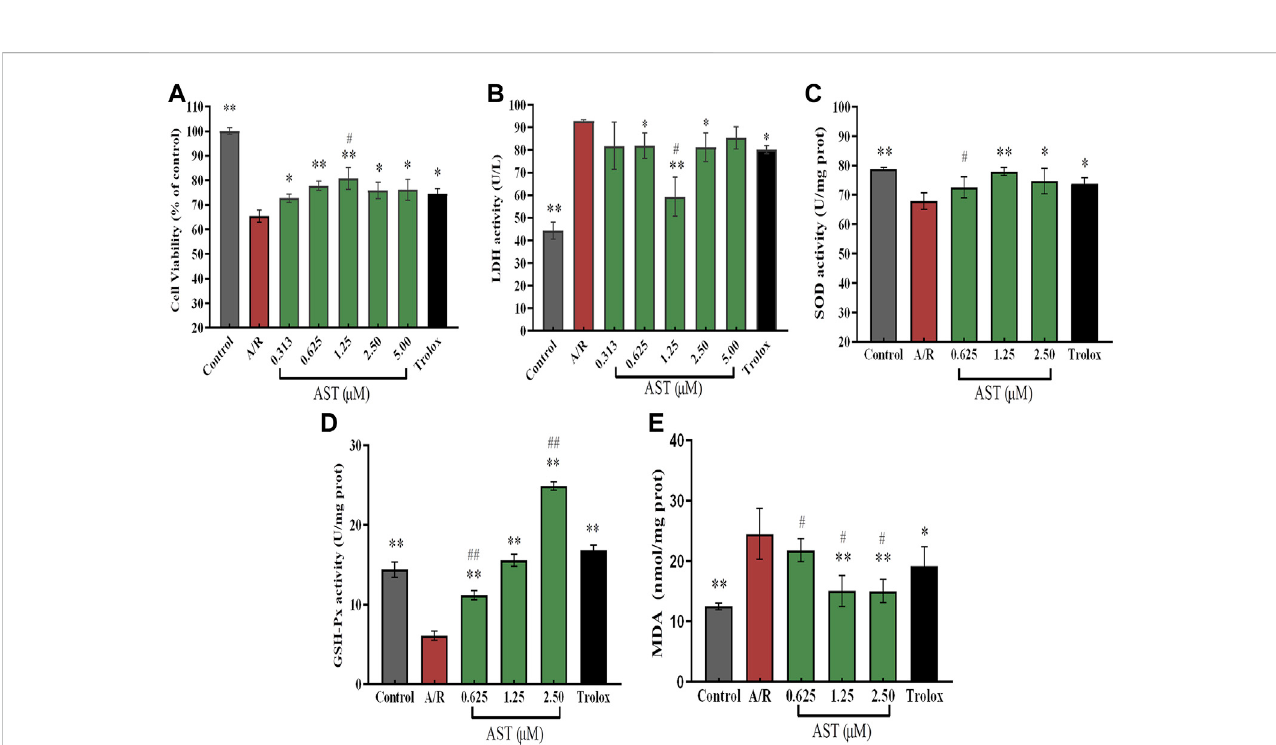
FIGURE 2 Astaxanthin alleviates A/R damage to H9c2 cardiomyocytes by maintaining cellular activity (A) , increasing expression of antioxidant enzymes (C,D) and reducing LDH and MDA levels (B, E) . *, vs. A/R group (* p < 0.05; ** p < 0.01); # , astaxanthin vs. Trolox group ( # p < 0.05; ## p < 0.01). A/R, anoxia reoxygenation; AST,